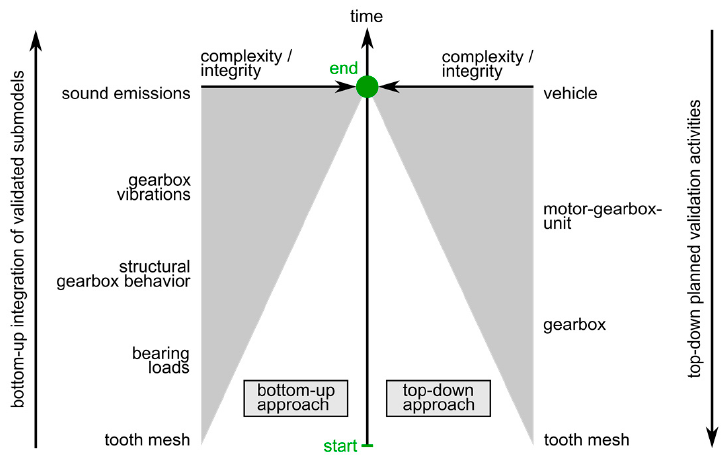
Figure 11. Both-ends-against-the-middle-approach (BEATM).